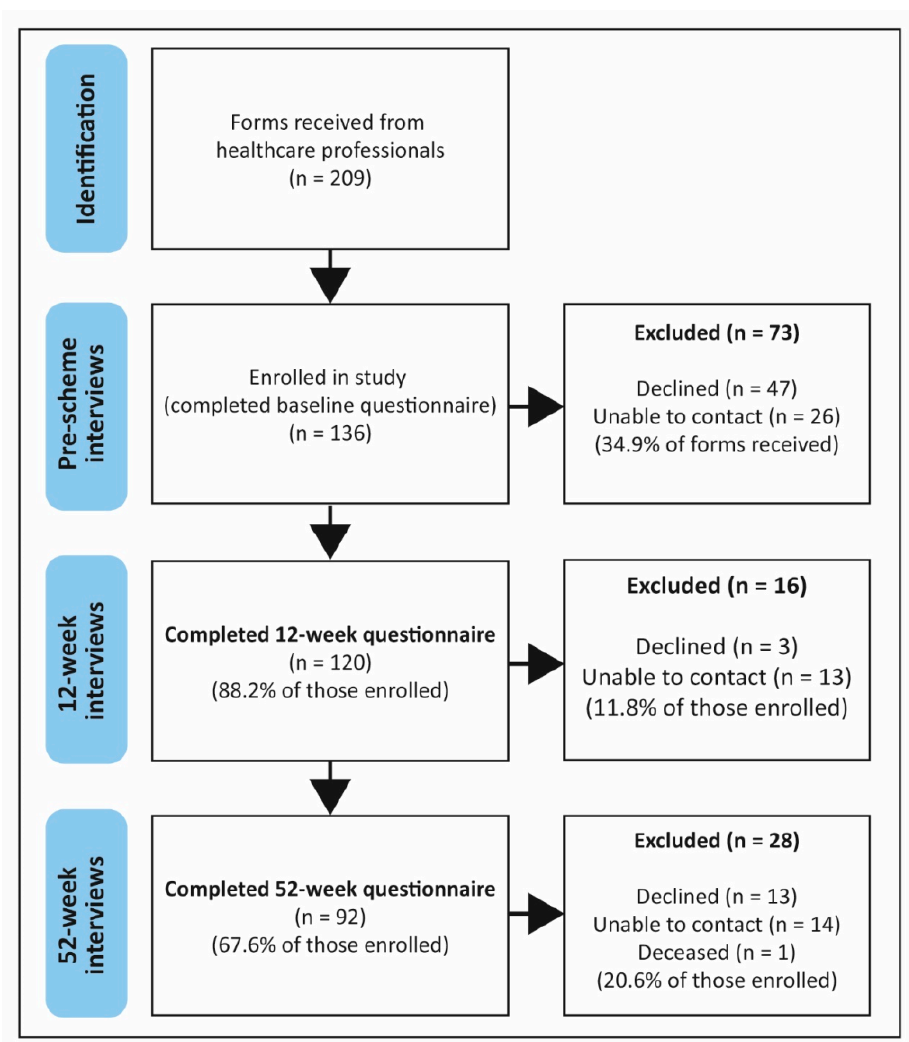
Figure 1. Study recruitment and participant